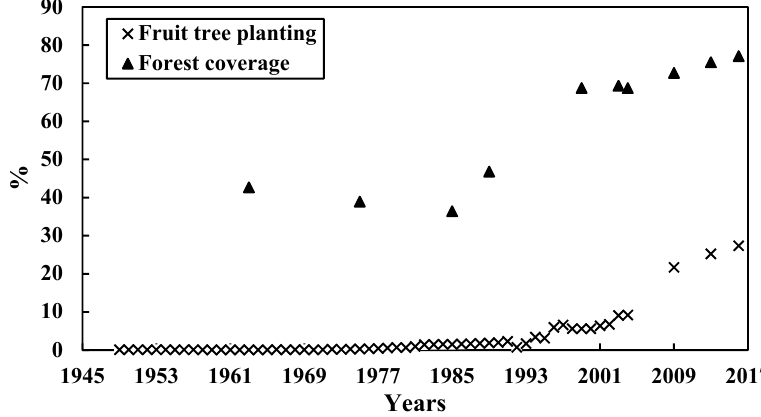
Figure 3. Forest changes (forest coverage and fruit tree planting) in the Jiujushui watershed.